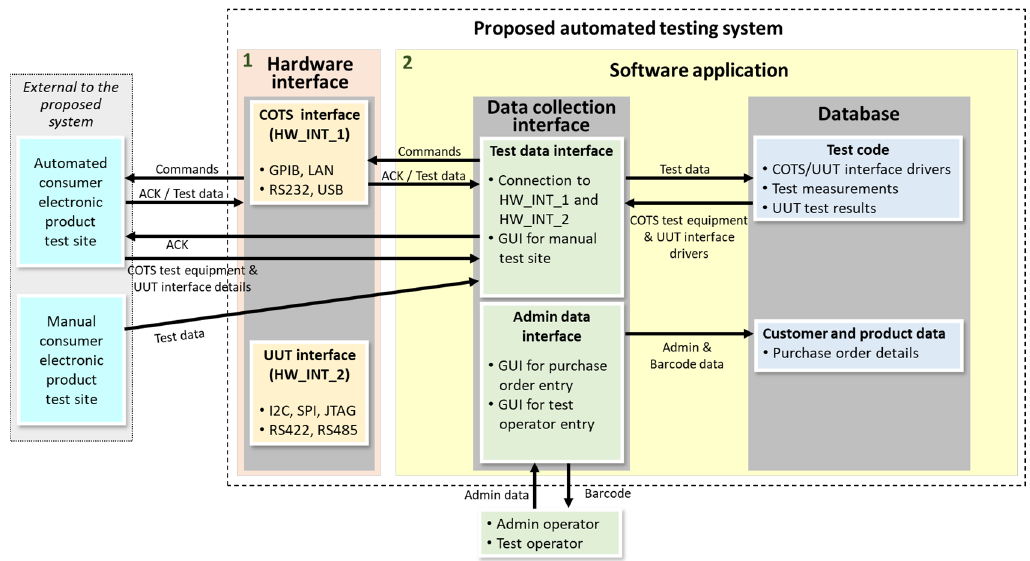
Figure 5. Proposed data collection sub-system data flow direction.